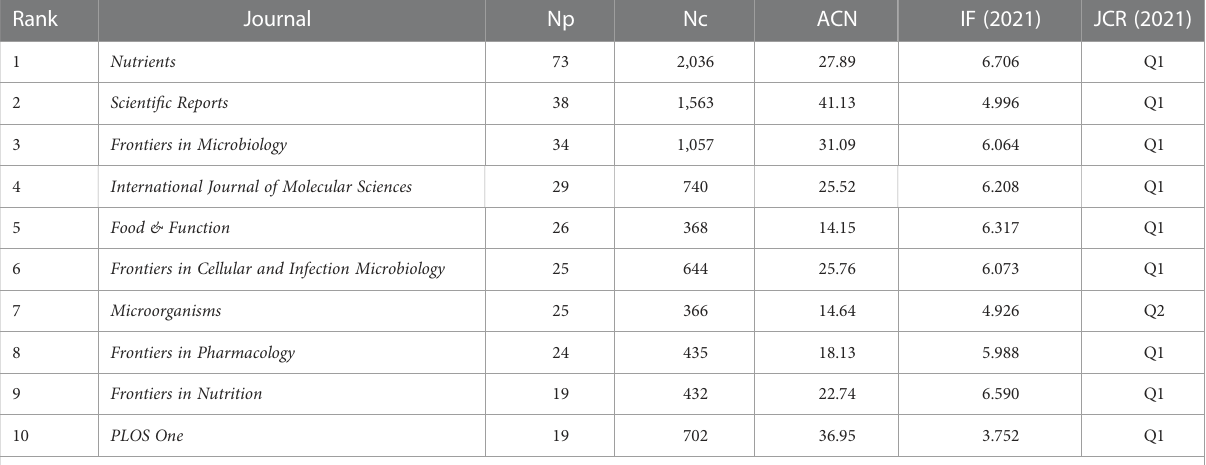
TABLE 5 The top 10 journals of GM in